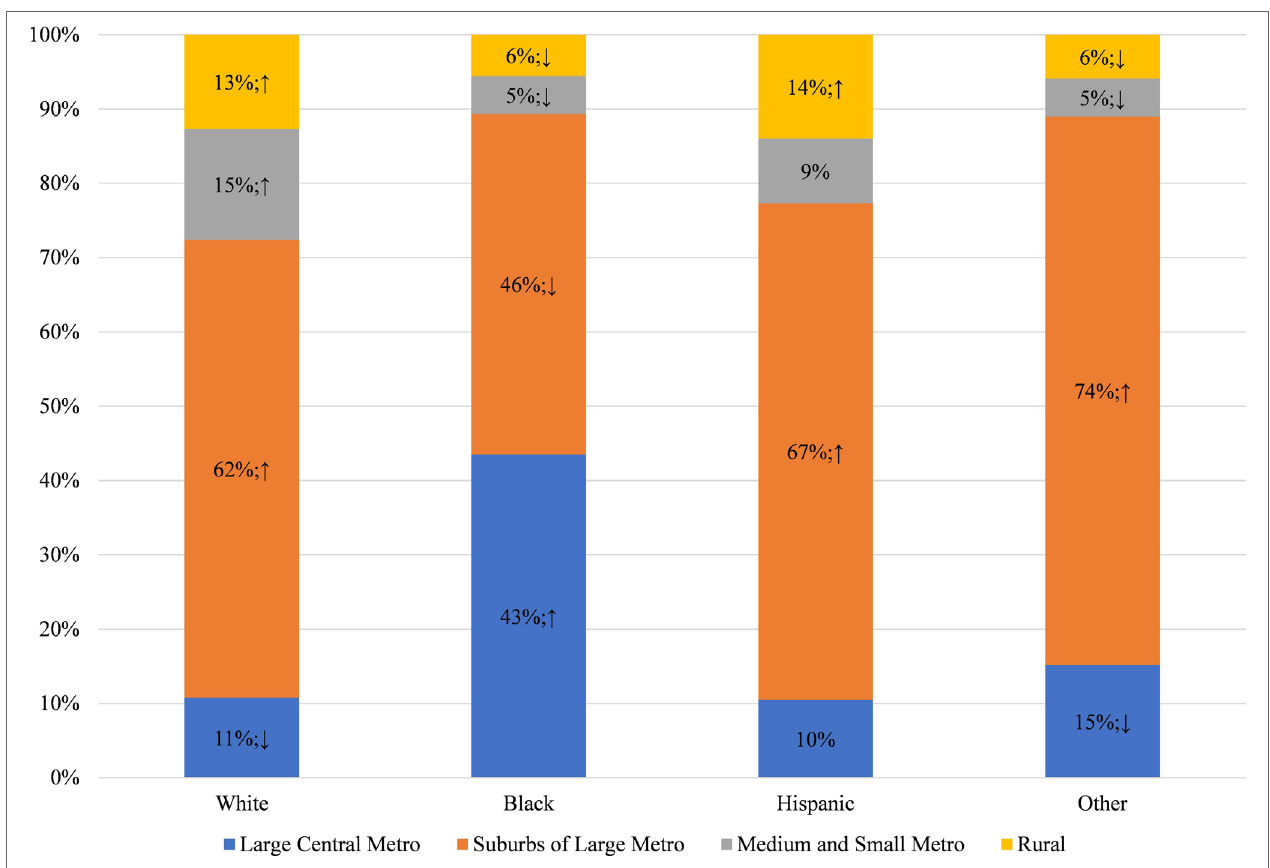
FigUre 4 | Location of residence of dental/oral health related conditions discharges, by race, in Maryland